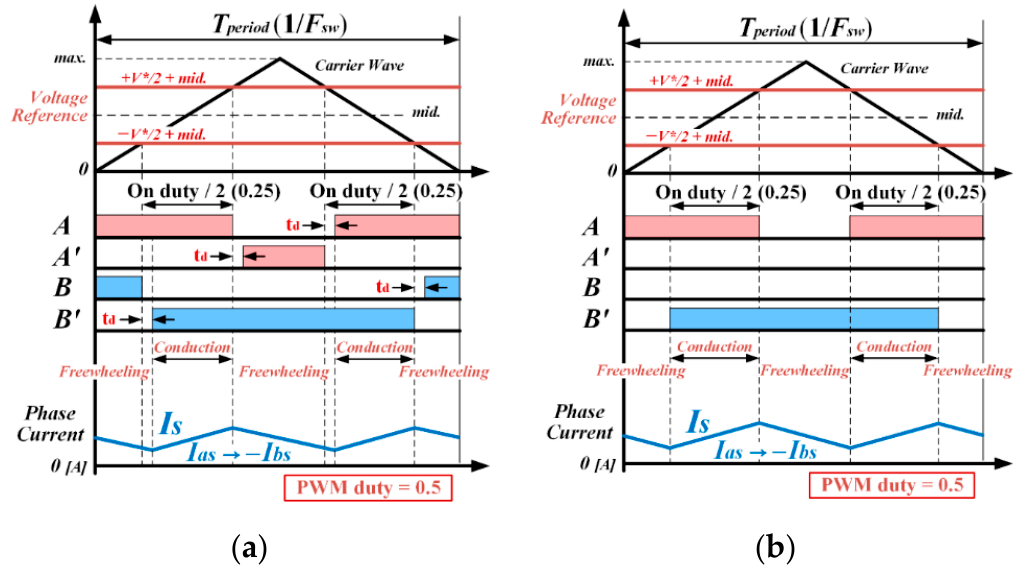
Figure 3. The PWM pattern of the H-PWM-L-PWM method in one switching cycle of Position Sector 1: ( a ) complementary switching mode; ( b ) non-complementary switching